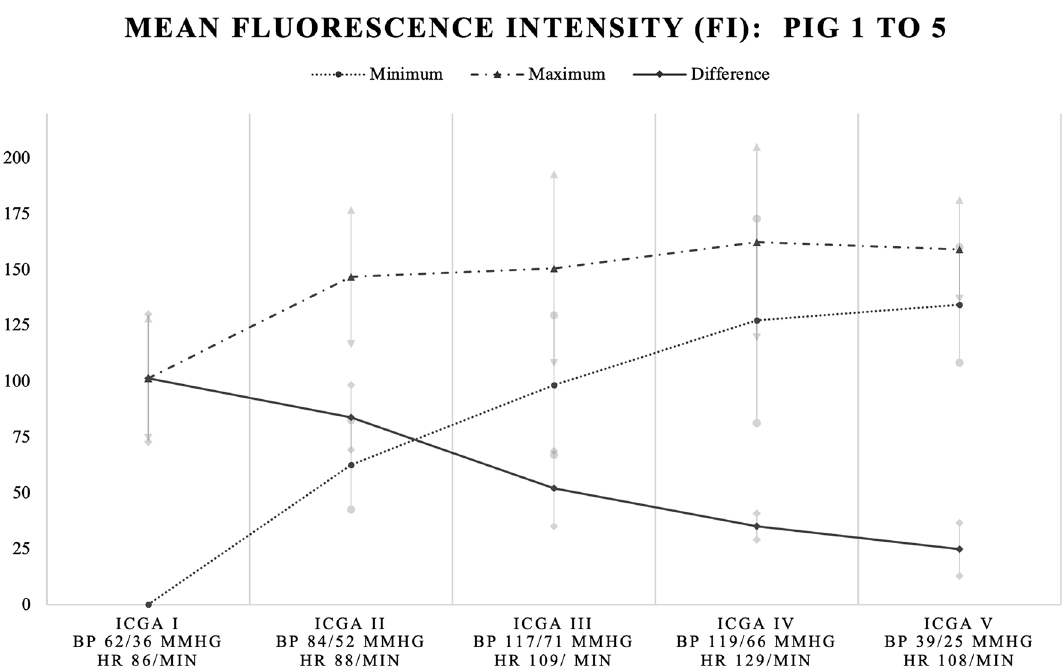
Figure 4. Mean minimum, maximum, and difference in absolute fluorescence intensity (FI) for all 5 pigs. Mean fluorescence intensity (in black) with standard deviations (in grey). X-axis: ICGA assessment number, mean BP and HR for all pigs. Y-axis: mean fluorescence intensity. ICGA indocyanine green angiography (I = baseline, II = after norepinephrine (NE) dose 1, III = after NE dose 2, IV = after NE dose 3, V = remnant measurement following discontinuation of NE), BP blood pressure, HR heart